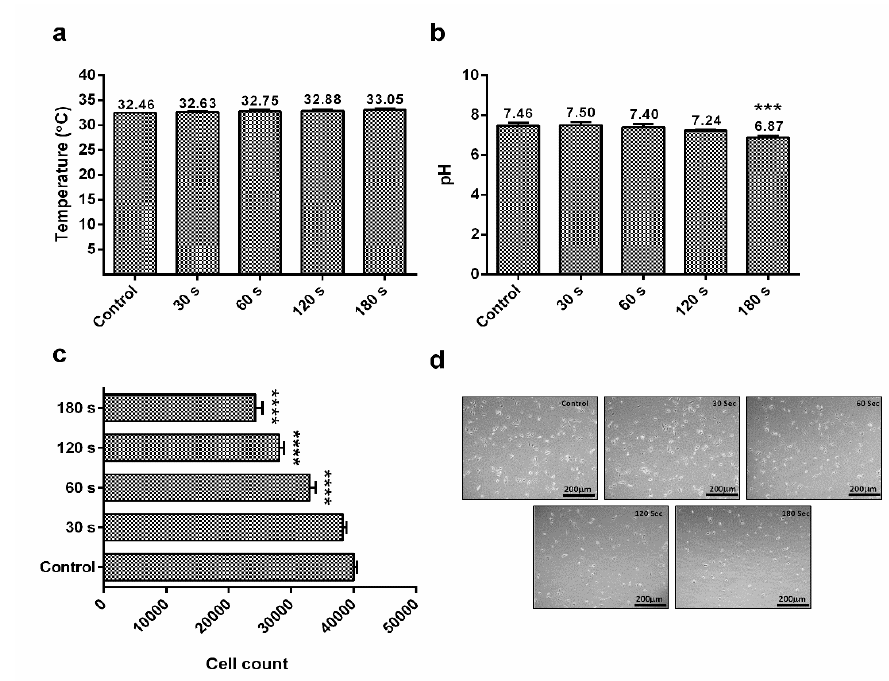
Figure 2. ( a ) Estimation of temperature within cell media (RPMI-1640) after the exposure of air CAP at di ff erent time intervals; ( b ) e ff ect of di ff erent CAP doses on the pH level of cell media; ( c ) assessment of the G-361 human melanoma cell count using a hemocytometer counter after the exposure of CAP at di ff erent time intervals; ( d ) microscopic evaluation of G-361 human melanoma cells at di ff erent CAP doses (scale bar = 200 µ m). Data are the mean ± SE of three experiments. Statistical analysis was performed using a one-way ANOVA test followed by Dunnett’s test for comparisons. Each asterisk represents statistical di ff erences between the treatment and control (*** p < 0.001 and **** p <